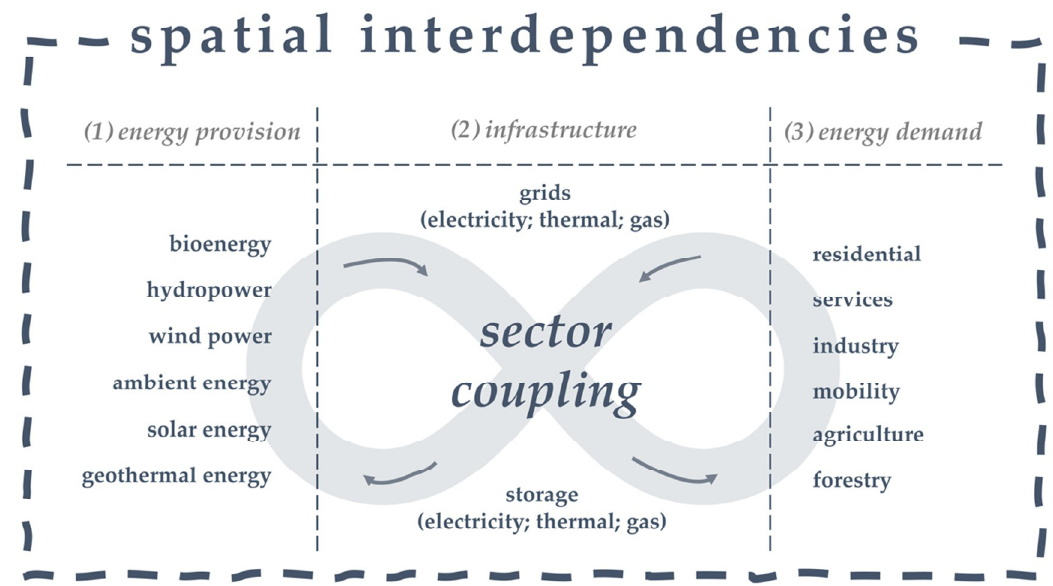
Figure 2. General system design—embedding sector coupling into spatial interdependency (own illustration based on